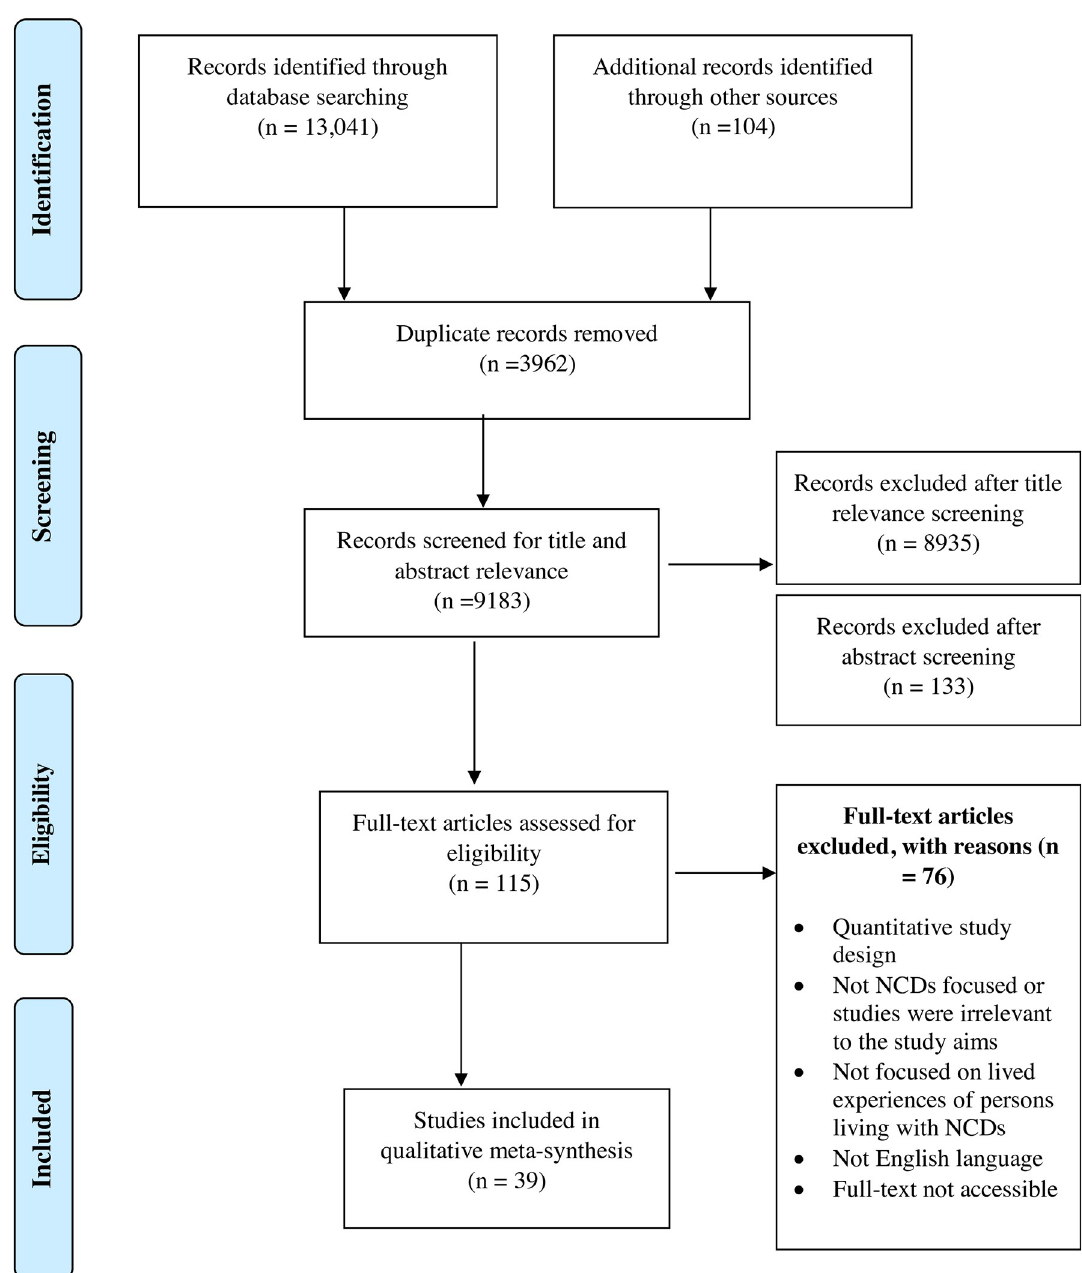
Fig 1. Flow chart of literature search and